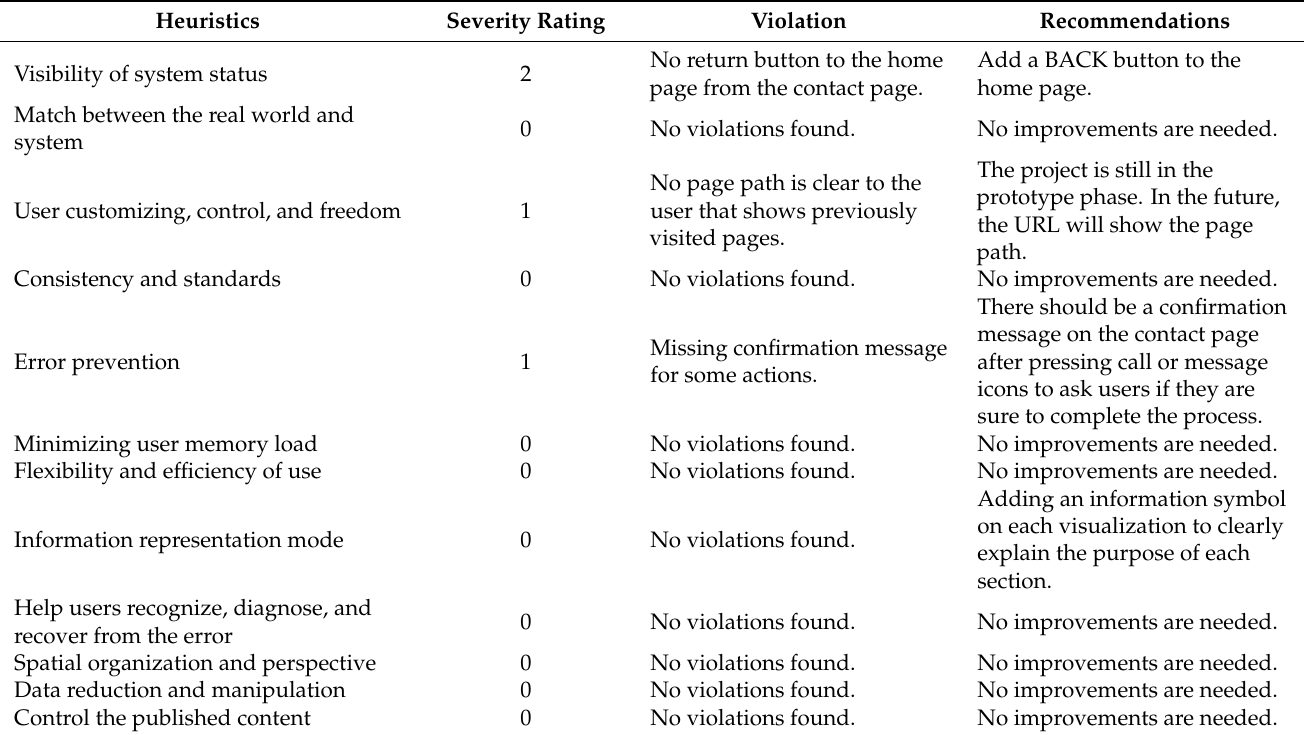
Table 4. Quantitative and qualitative results of the heuristic evaluation of proposed